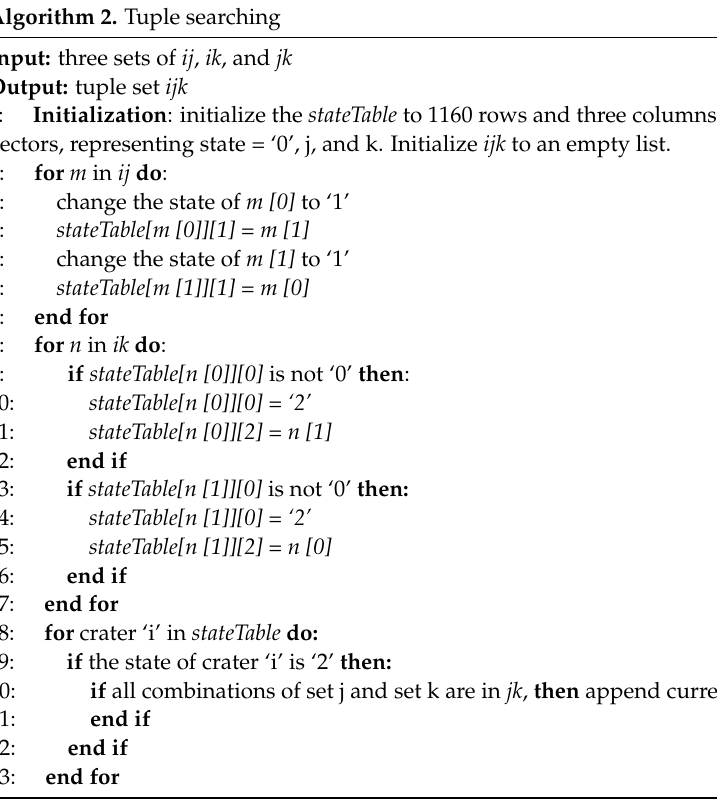
Algorithm 2. Tuple